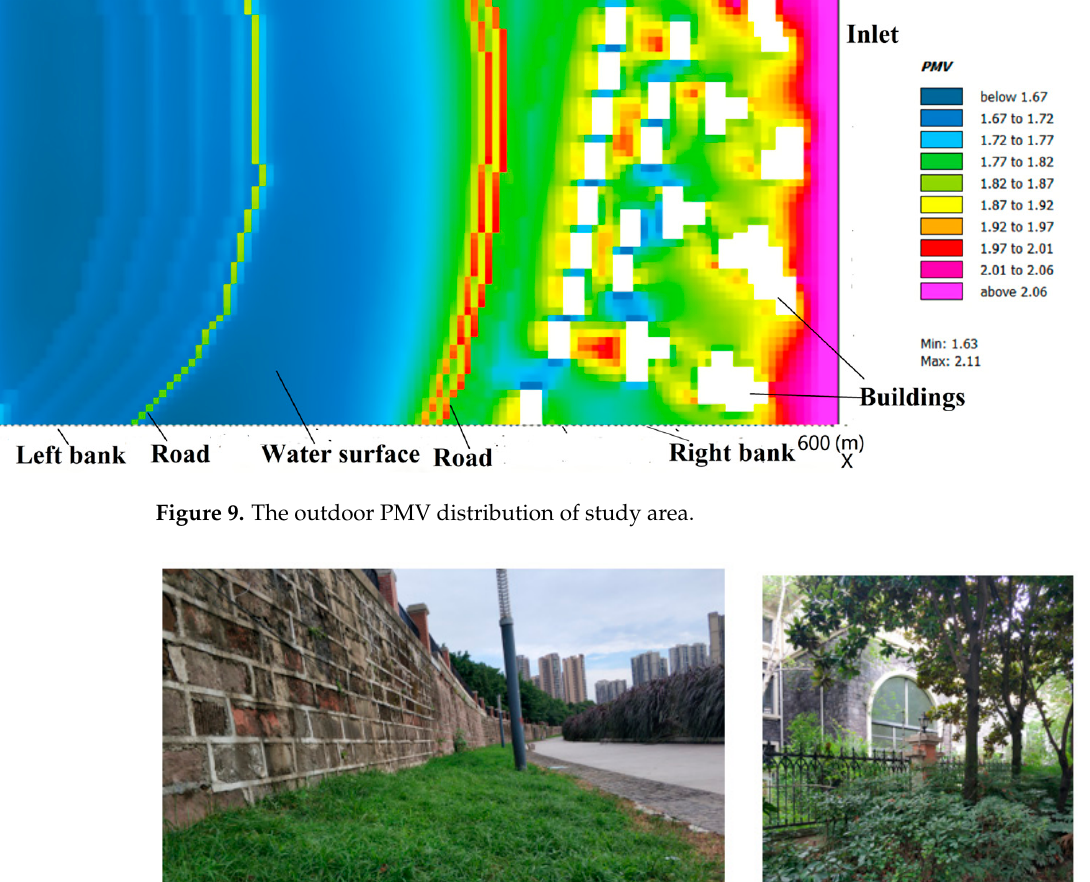
Figure 10. The real scene picture ( a ) road ( b ) residential area.